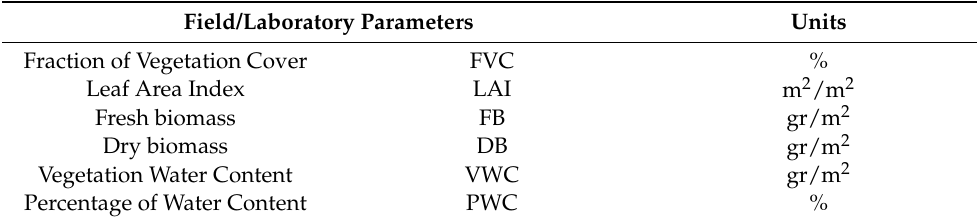
Table 1. List of the field and laboratory parameters used in the